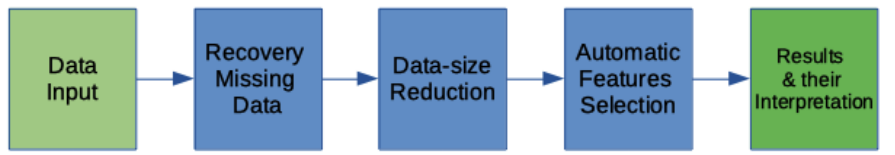
Figure 1. Block diagram of the proposed automatic variable selection model.